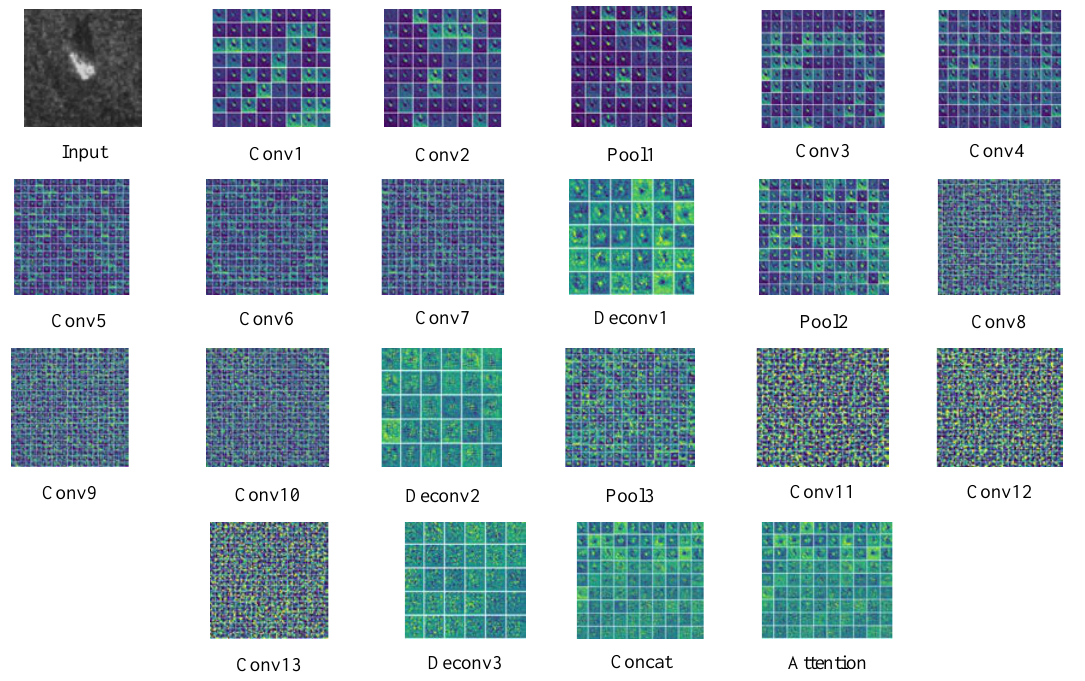
Figure 6. Visualization of MFFA-SARNET layers.